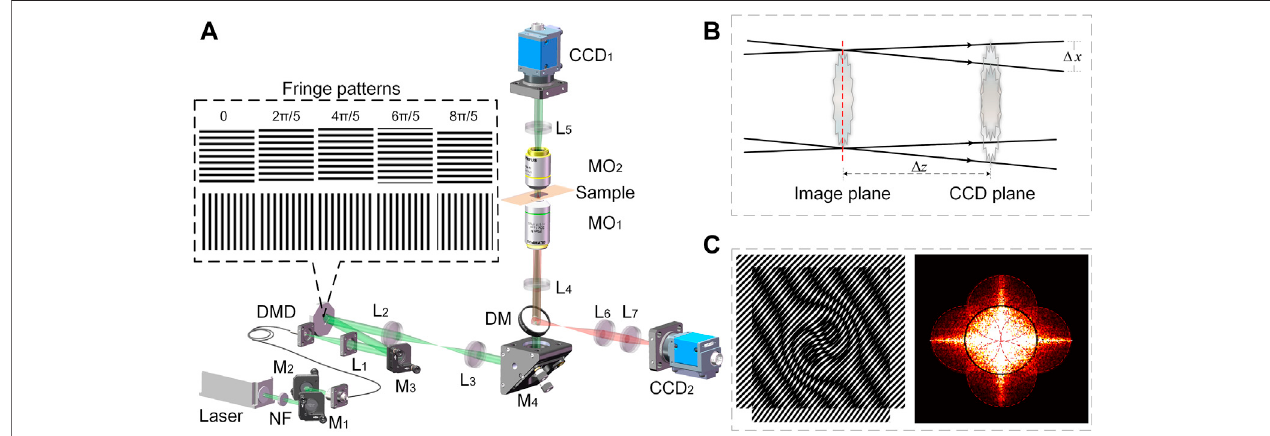
FIGURE 1 | The schematic diagram of DMD-based SIM apparatus for multi-modality imaging. (A) Experimental setup. Insets: structured illumination patterns (B) lateral shearing of the ± 1 orders in qDIC modality; (C) resolution enhancement upon structured illumination. DM, dichroic mirrors; L 1 -L 7 , achromatic lens; MO 1 -MO 2 , microscopic objectives; M 1 -M 4 , mirrors; NF, neutral density fi